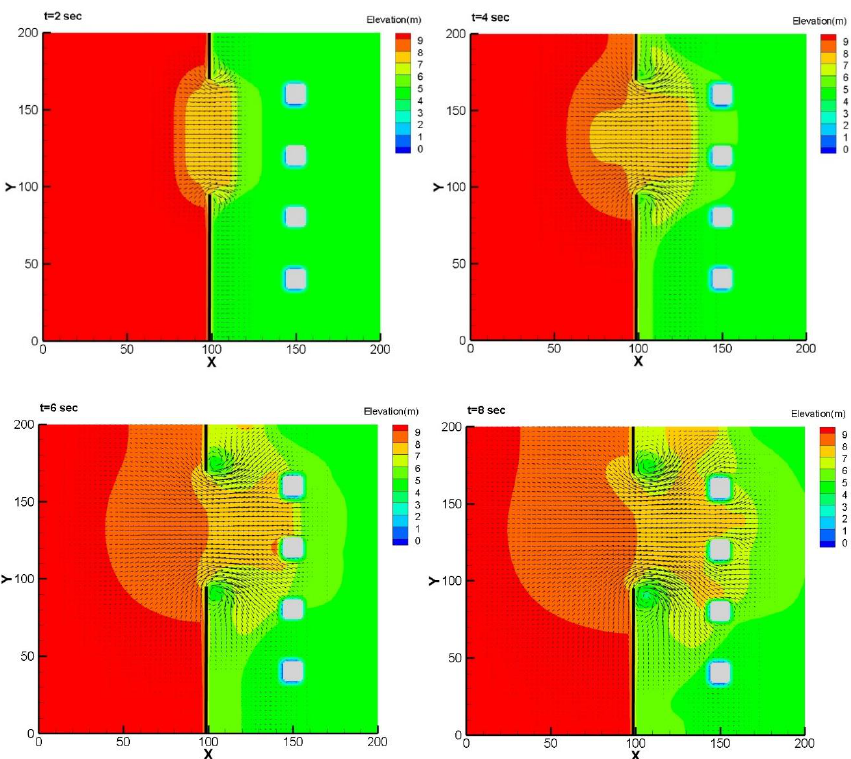
Figure 16. Evolutions of the free surface elevations and velocity distribution with four square cylinders where the S x = 0.02 at the downstream.